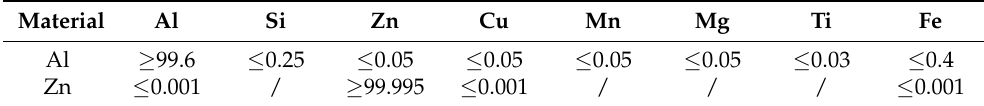
Table 1. Chemical compositions of 1060 Al plate and pure Zn ingot